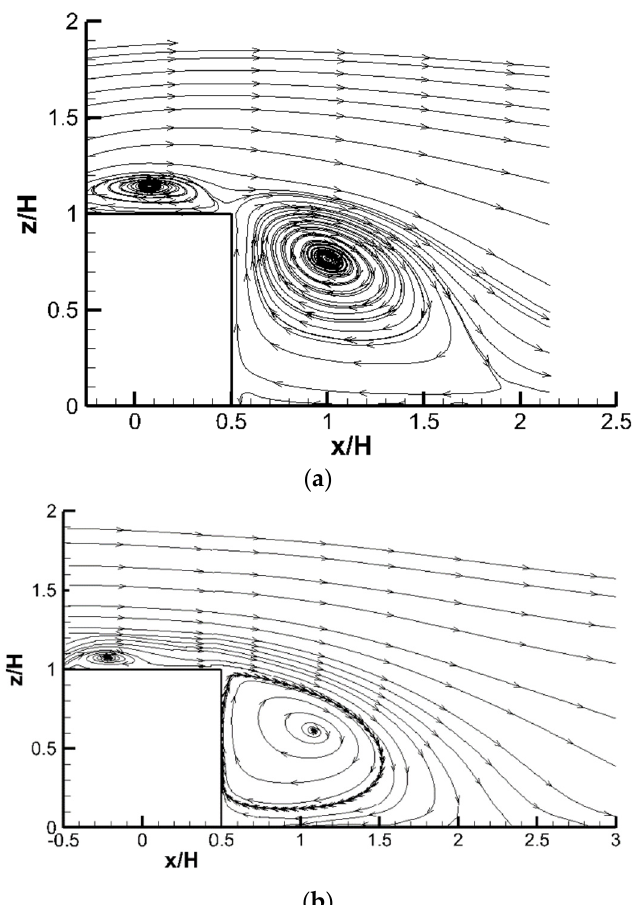
Figure 3. Mean streamlines downstream of the cylinders ( H = D = 50 mm): ( a ) cube; ( b ) cylinder.